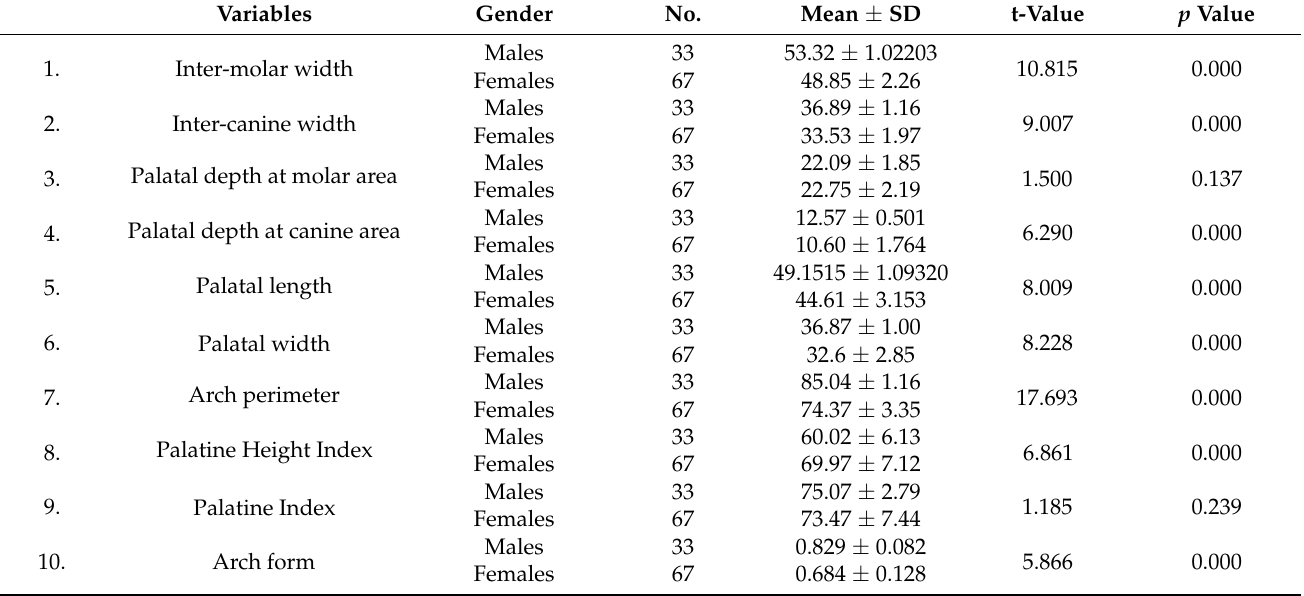
Table 3. Gender differences of different variables of the study